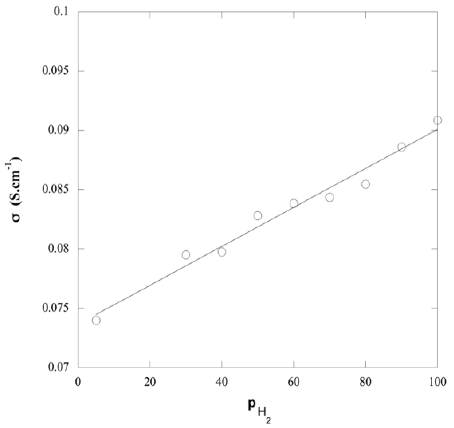
Figure 7. Conductivity of BZY–LK30 as a function of p H2 at 500